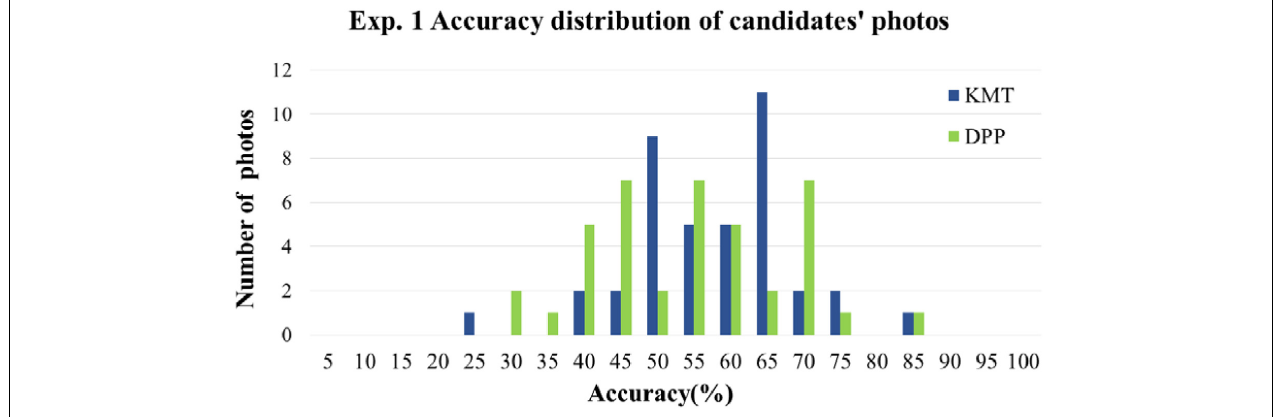
FIGURE 3 | The distribution of item difficulties in Experiment 1, measured by the percentage correct collapsed across participants. The abscissa denotes the categorization accuracy of the candidates’ photos in 5% bins; the ordinate denotes the number of photos.